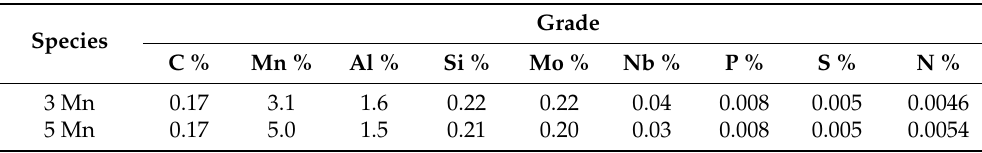
Table 1. Chemical compositions of the investigated medium-Mn steels.